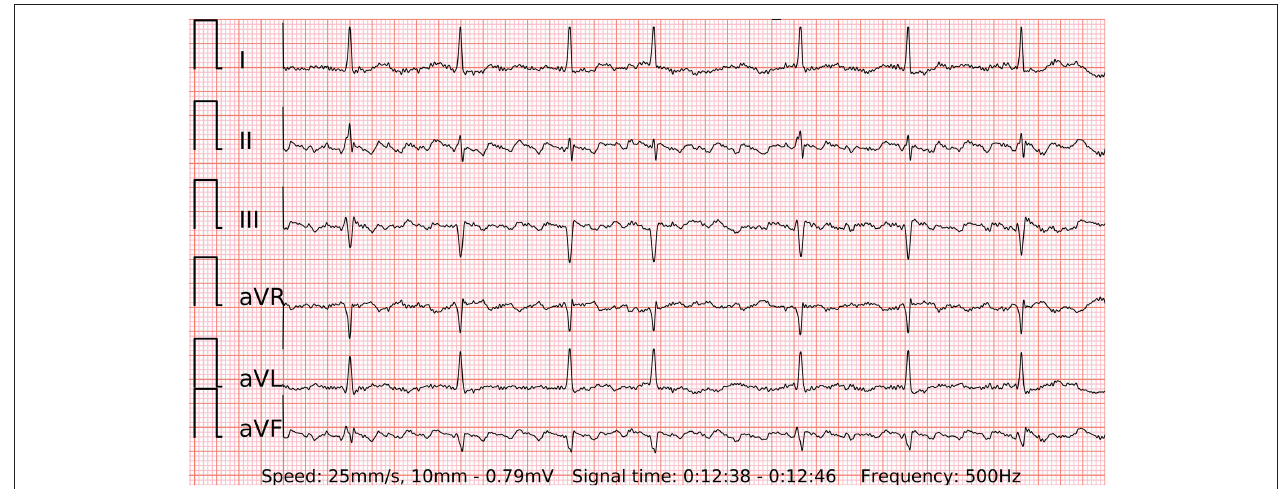
FIGURE 7 | A 6-lead ECG of typical counterclockwise atrial flutter with variable atrioventricular conduction recorded by the wearable